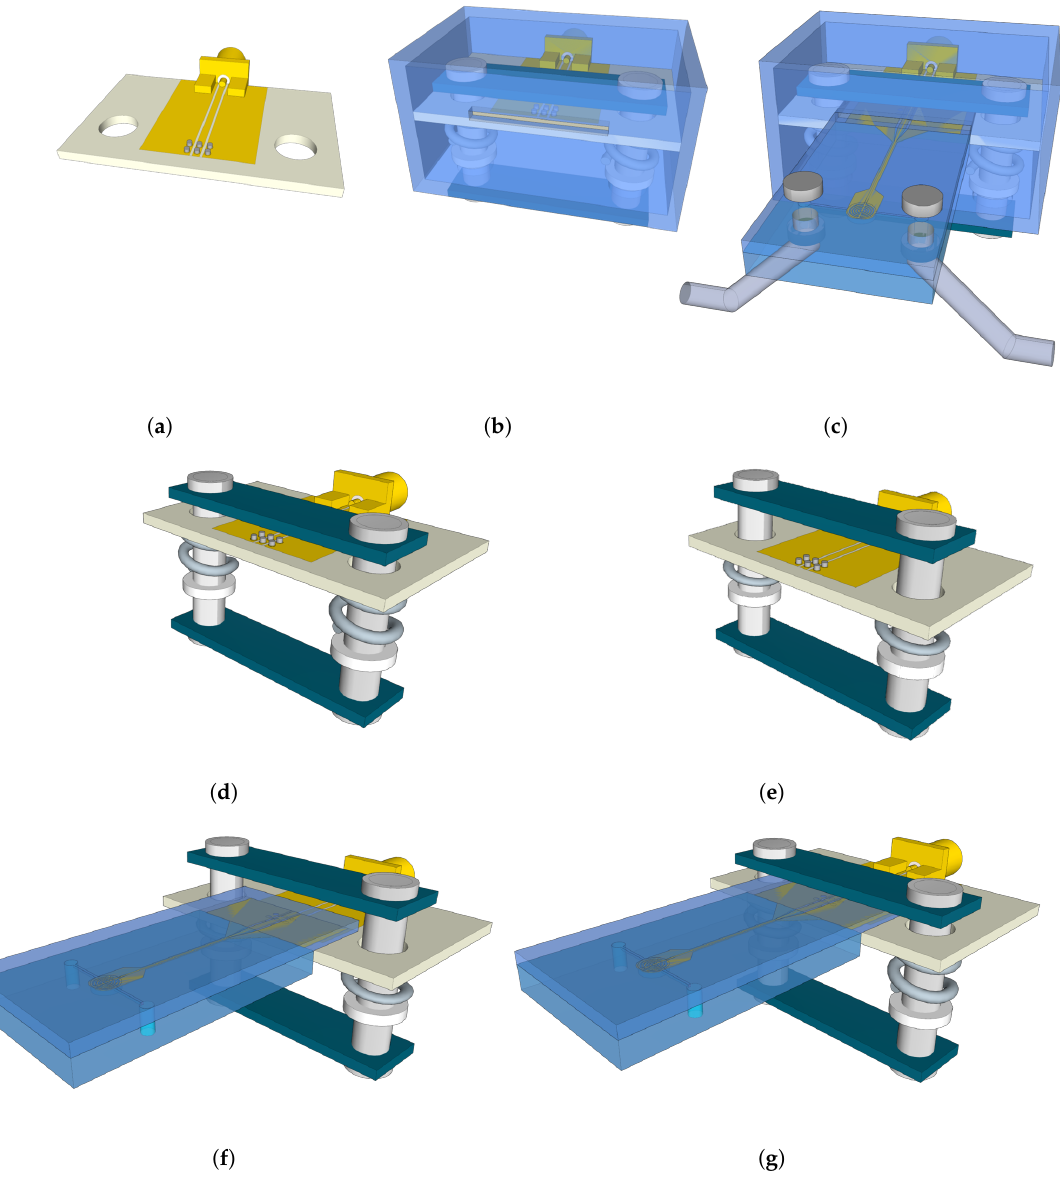
Figure 1. ( a ) A printed circuit board (PCB) with an subminiature type A (SMA) connector and Invisipins. ( b ) A polymethyl methacrylate (PMMA) enclosure with the PCB. ( c ) An interconnect box (ICB) loaded with a consumable microwave-microfluidic chip. ( d ) The initial position for the loading of the chip. ( e ) Compression of springs prior to the loading of the chip. ( f ) Loading of the chip and positioning over Invisipins. ( g ) Releasing of the spring-levered handle and finalizing the loading of the